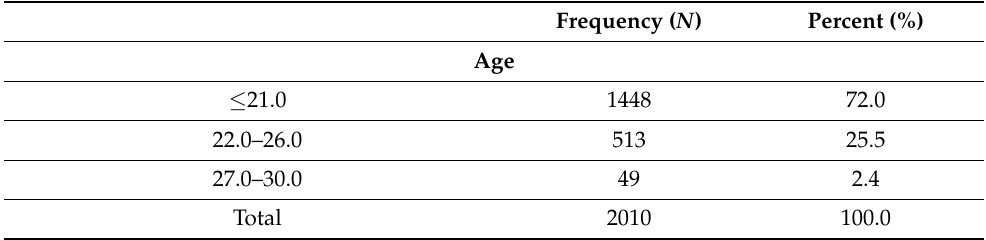
Table 2. Categorical distribution of demographic